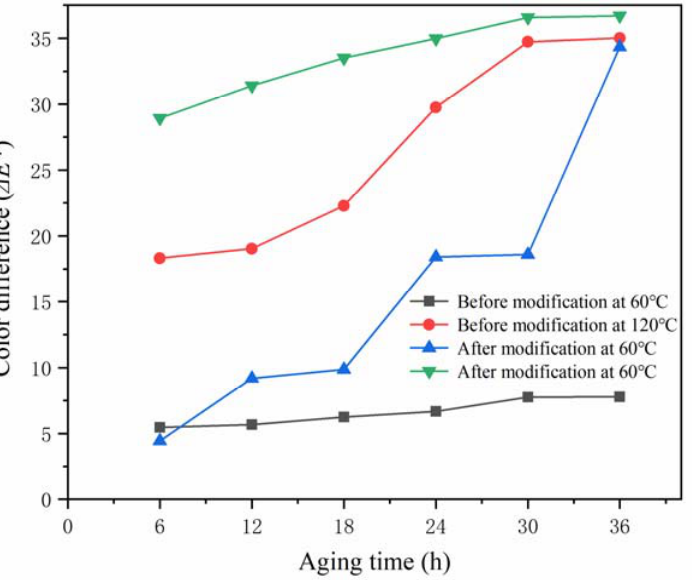
Figure 1. Changes in the color difference values of the shellac before and after modification. Table 5. Change in the gloss of the shellac before and after modification.